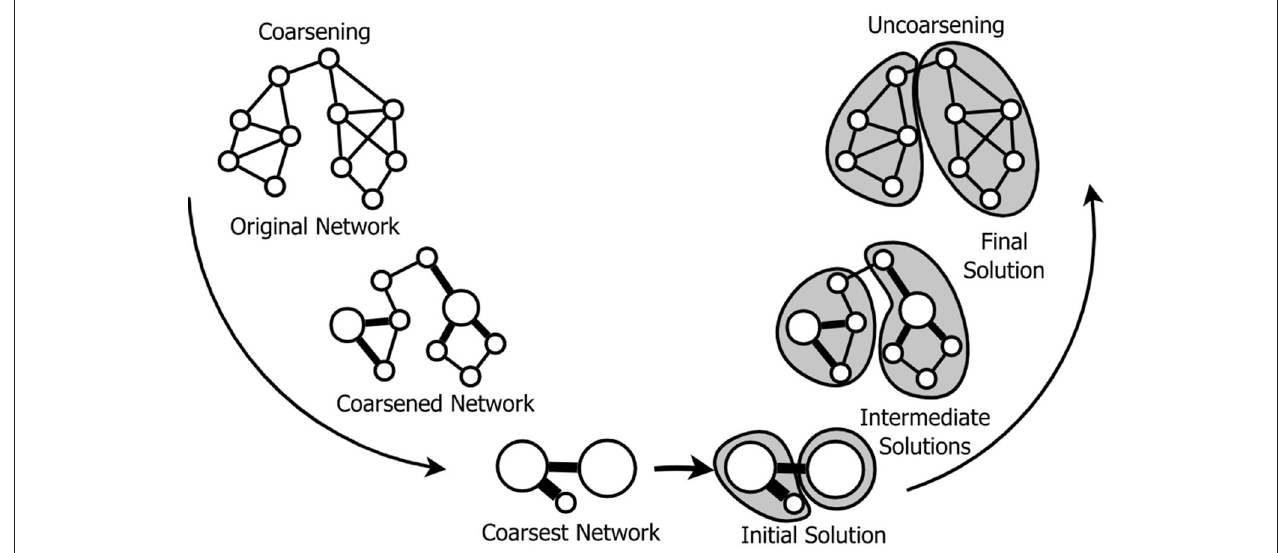
FIGURE 1 | Phases of a general multilevel optimization method operating on a network. (i) Coarsening: computes a sequence of incrementally simpler networks. (ii) Solution finding: computes an initial solution executing a target algorithm in the coarsest network. (iii) Uncoarsening: projects this solution back up to the original